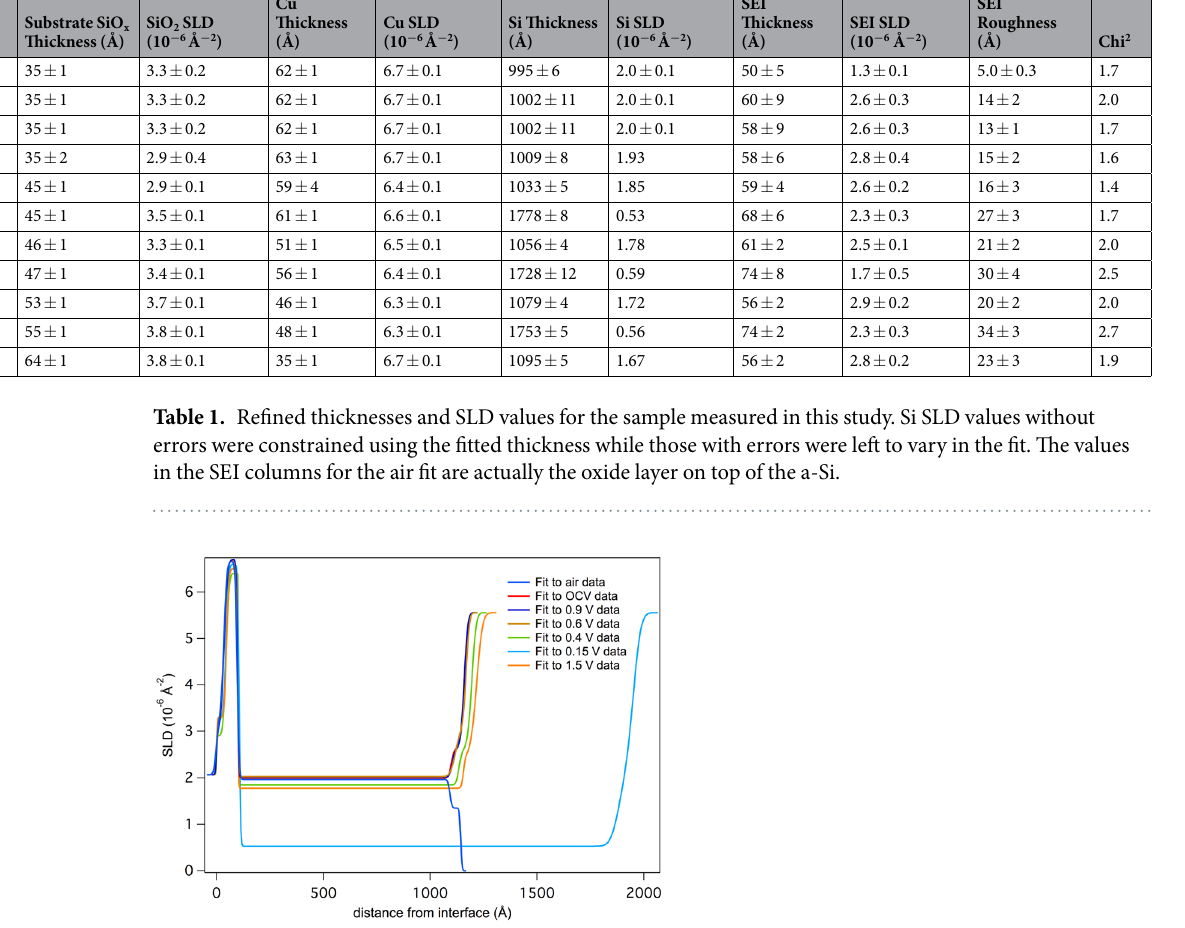
Figure 2. Plot of the refined SLD profile of the film as a function of distance from the thick Si substrate.